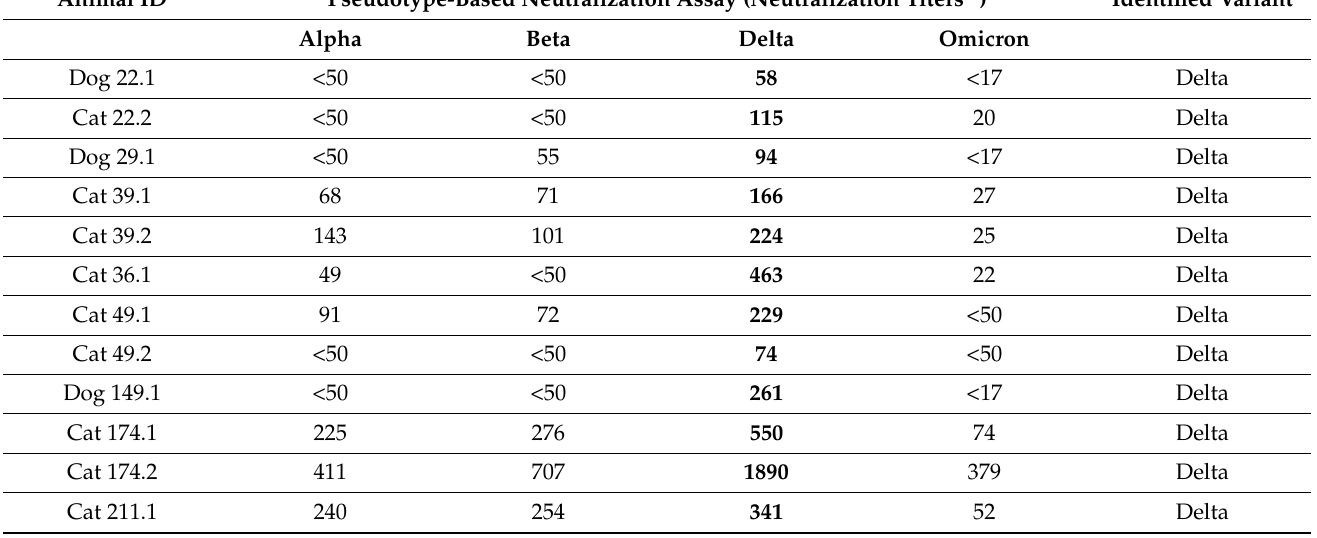
Table 5. Pseudotype-based neutralization assay (PVNT) results: variant-specific antibodies for Alpha, Beta, Delta, or Omicron variants.